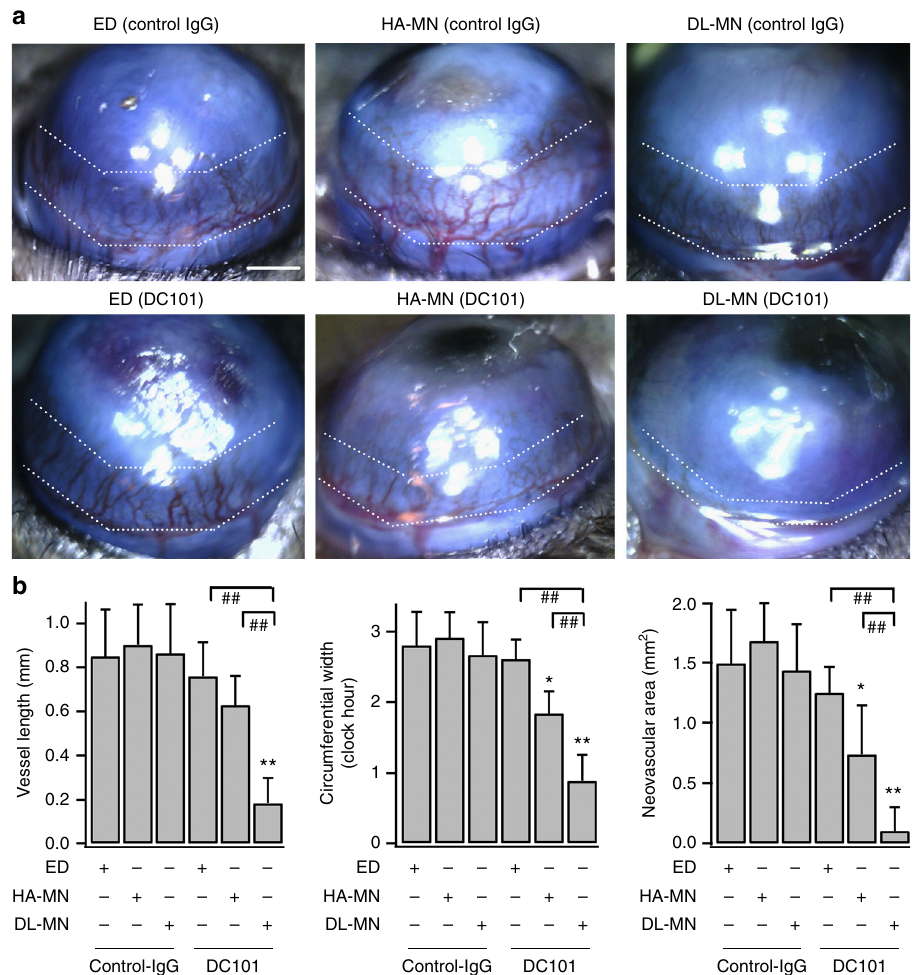
Fig. 7 DL-MN patch improves the therapeutic ef fi cacy of anti-VEGF therapy. Mouse eyes were treated differently 2 days after being in fl icted with alkali- burn, and examined at day 7. a Representative images of differently treated eyes and b quanti fi cations of corneal neovascularization (mean ± SEM; 6 samples for each group). Scale bar = 500 µ m. The white dotted lines indicate the extent of neovascular outgrowth from the limbus. Statistical comparison between groups was performed using one way ANOVA. * p < 0.05, ** p < 0.01 vs. control (control IgG eye drop, ED); ## p < 0.01 between indicated